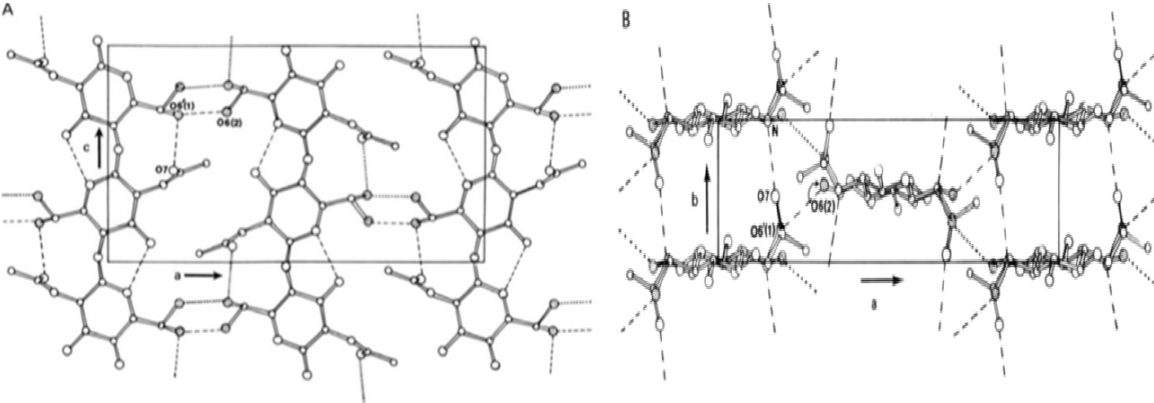
Figure 2. Structure of α chitin. ( A ) ac projection; ( B ) ab projection. The branching of the atoms indicates the alternate positions for the oxygen of the CH 2 OH group [23].